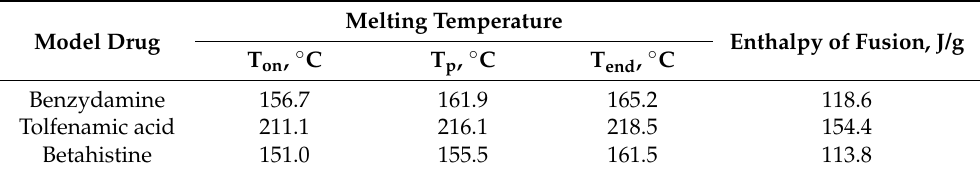
Table 3. Differential scanning calorimetry (DSC) parameters (melting temperature and enthalpy of fusion) of the model drugs incorporated in polyelectrolyte multilayer films.